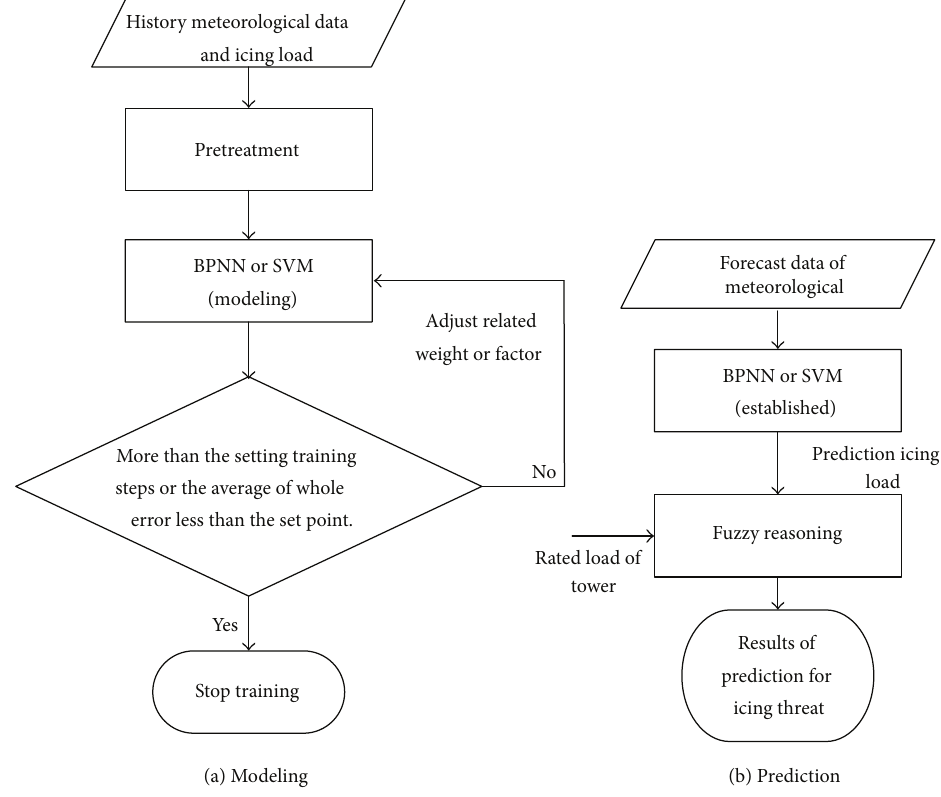
Figure 3: The process of modeling and